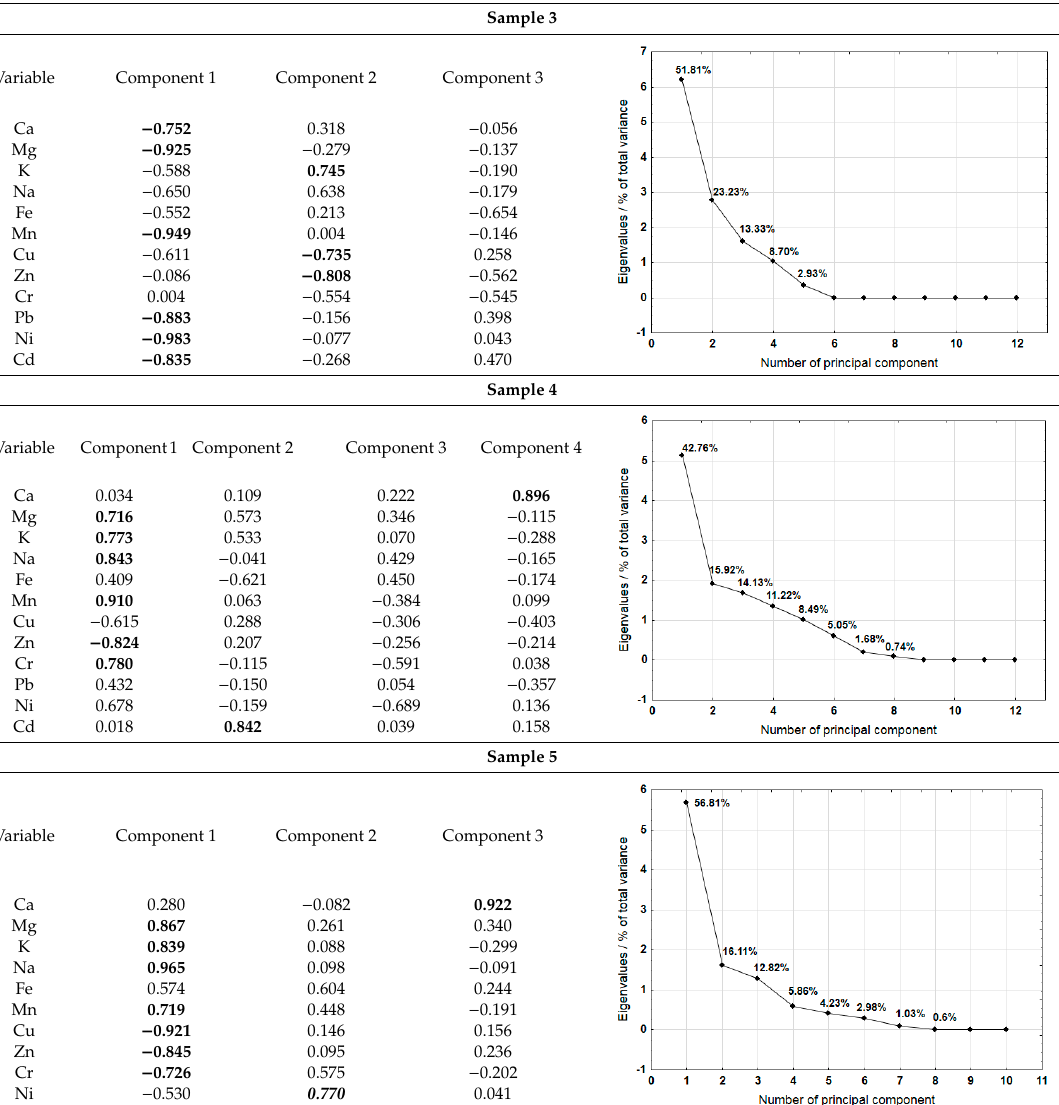
Table 8. The results of the Principal Component Analysis (PCA) for samples 6, 7, and